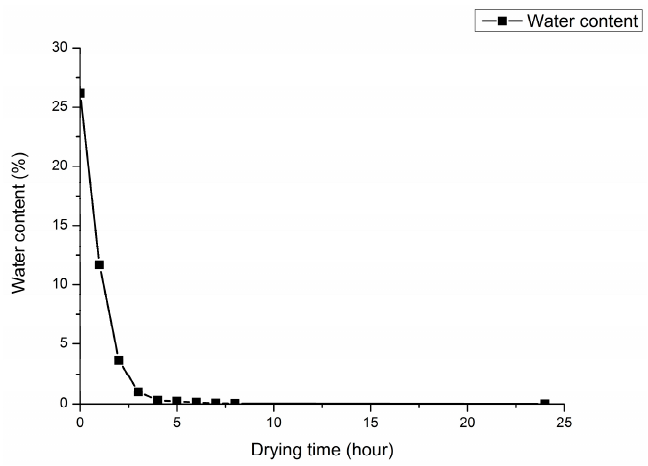
Figure 7. The relationship between soil water content and drying time.